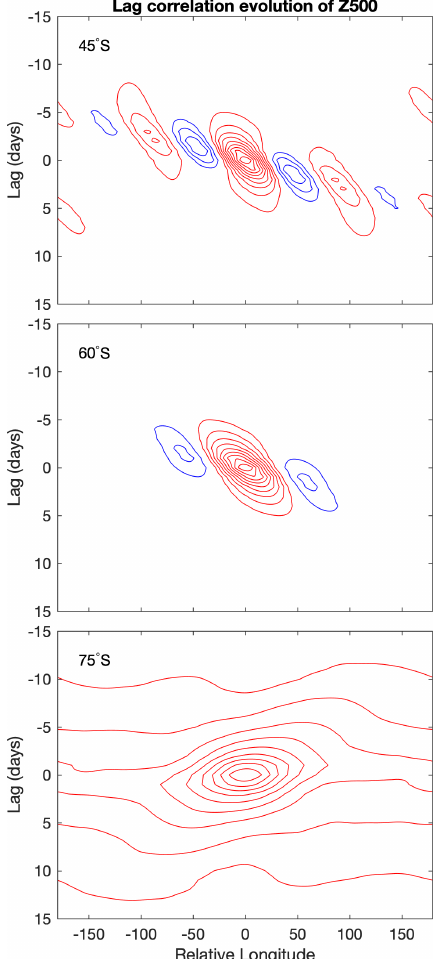
Figure 7. Examples of lag correlation analysis of daily mean Z 500 from the NCEP2 reanalysis applied to the Southern Hemisphere in DJF. For each latitude (45, 60, and 75 ◦ S), analysis was performed for 12 base points equally spaced around the hemisphere and then the resulting correlation patterns were averaged. The contour inter- val is 0.1 with the zero correlation lines